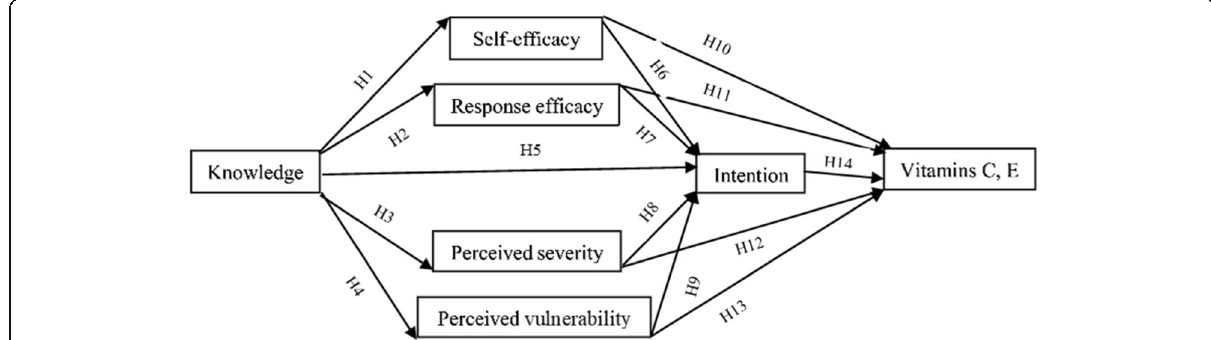
Fig. 1 Path diagram of the hypothesized relationships. H,